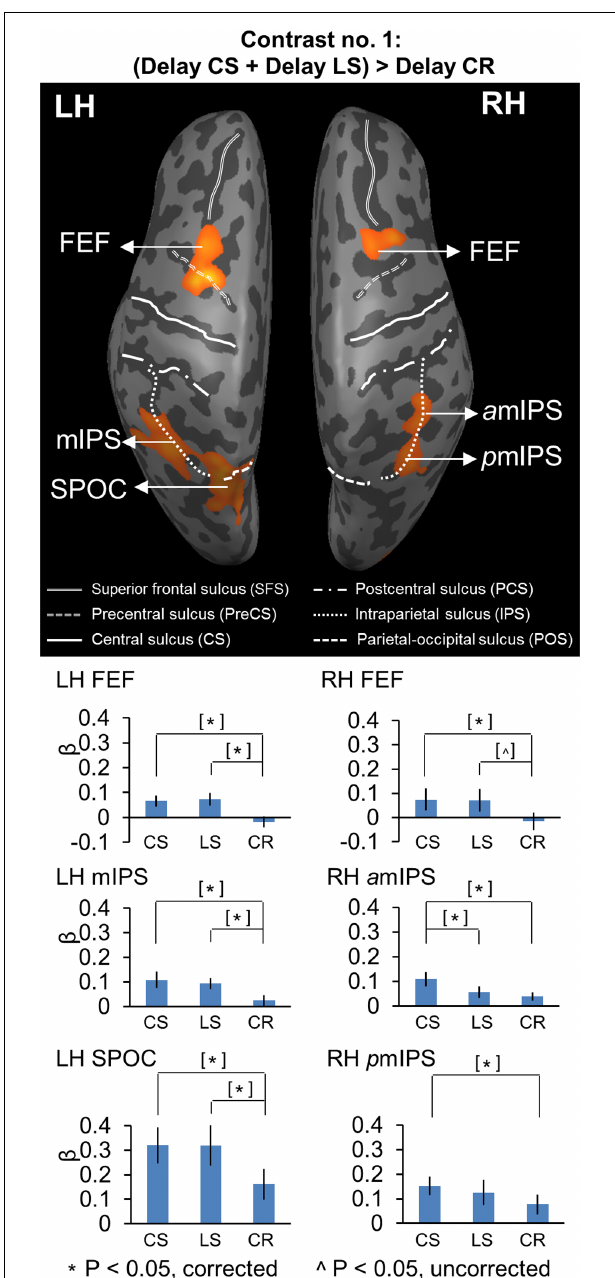
FIGURE 2 | Voxelwise statistical map obtained with the RFX GLM and activation levels for each area using Contrast no. 1 [(Delay CS + Delay LS) > Delay CR]. Top panel: activation map rendered on the inflated brain of one representative participant. Bottom panel: bar graphs show the β weights for the three tasks in each area. CS, Control Saccade task. LS, Landmark Saccade task. CR, Color Report task. [ ∗ ] Significant difference between two tasks for p < 0.05, non-independent of the criteria used to select the area. [ˆ] Significant difference between two tasks for p < 0.05, uncorrected, non-independent of the criteria used to select the area. Error bars indicate 95% confidence intervals. FEF corresponds to the anatomic area at the intersection between precentral sulcus and superior frontal sulcus, and was classified based on the neuroimaging literature on saccades (Paus, 1996; Luna et al., 1998).